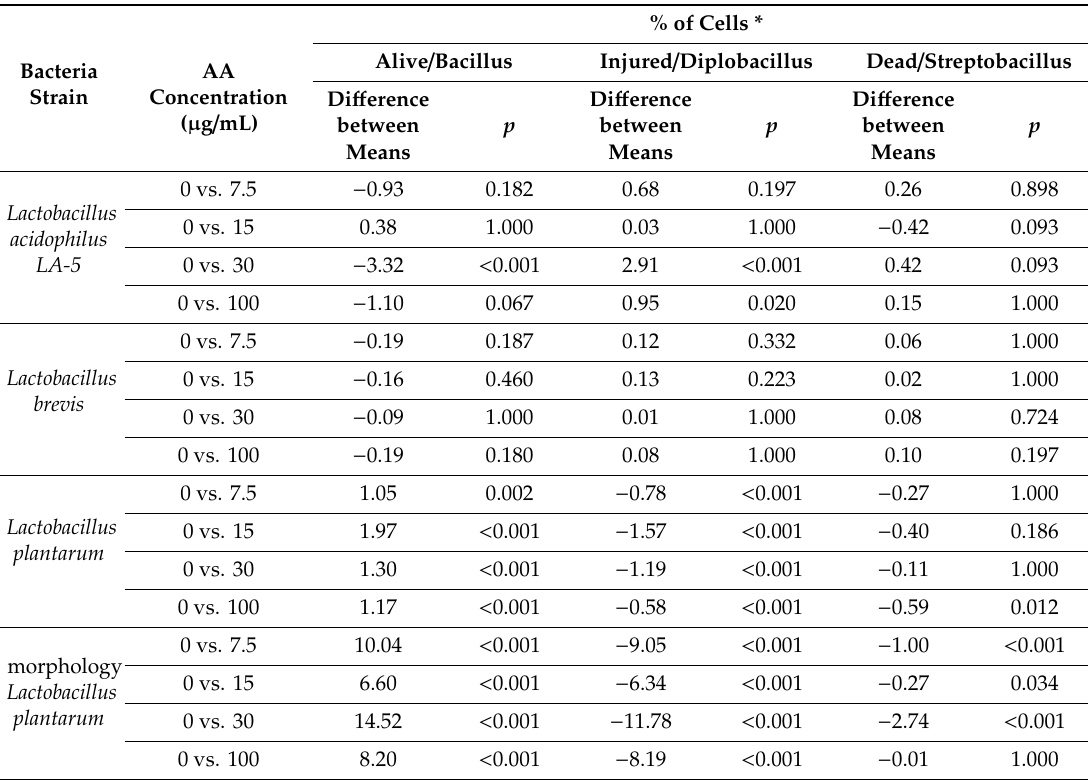
Table 4. The main e ff ect of acrylamide concentration: posthoc Bonferroni test.